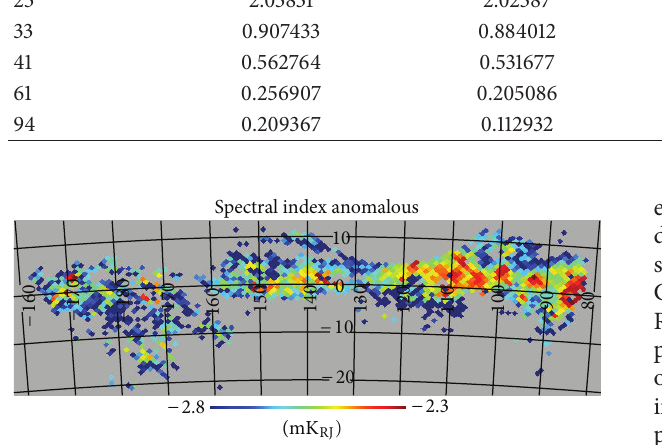
Figure 4: Map of the spectral index of the anomalous emission ( right